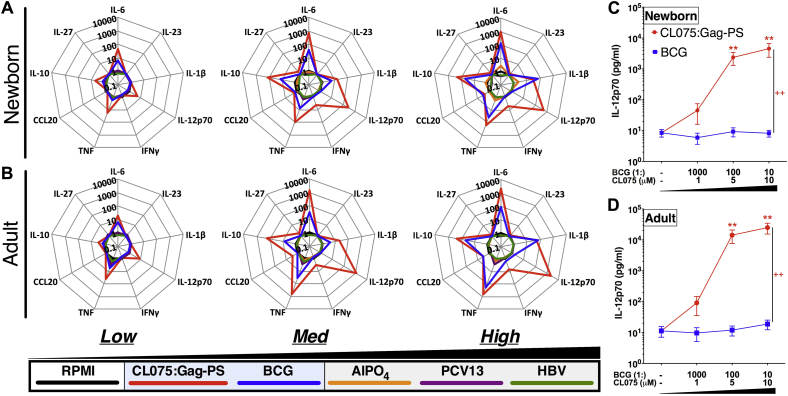
TLR8 agonist–encapsulating polymersomes match or exceed BCG's cytokine-inducing activity, dramatically enhancing human neonatal and adult MoDC IL-12p70 production. Newborn (A and C) and adult (B and D) MoDCs were cultured in 10% (vol/vol) autologous plasma and stimulated for 24 hours with increasing concentrations of CL075:Gag-PS (red; 1, 5, and 10 μmol/L), BCG (blue), PCV13 (purple), HBV (green; each at 1:1000, 1:100, and 1:10 vol/vol), or alum (5, 50, 500 and μg/mL; orange). Concentration-dependent cytokine production induction was measured in supernatants by using the multiplex assay. Data represent fold change over vehicle control (black; mean ± SEM, n = 6). For analyses of individual treatments (eg, control 10 μmol/L CL075:Gag-PS vs BCG 1:10 [vol/vol]), the unpaired Mann-Whitney test was applied at each concentration, and statistical significance was denoted as follows: **P < .01. For comparisons between overall groups (eg, CL075:Gag-PS vs BCG), significance was denoted as follows: ++P < .01. See also Figs E9 and E10.